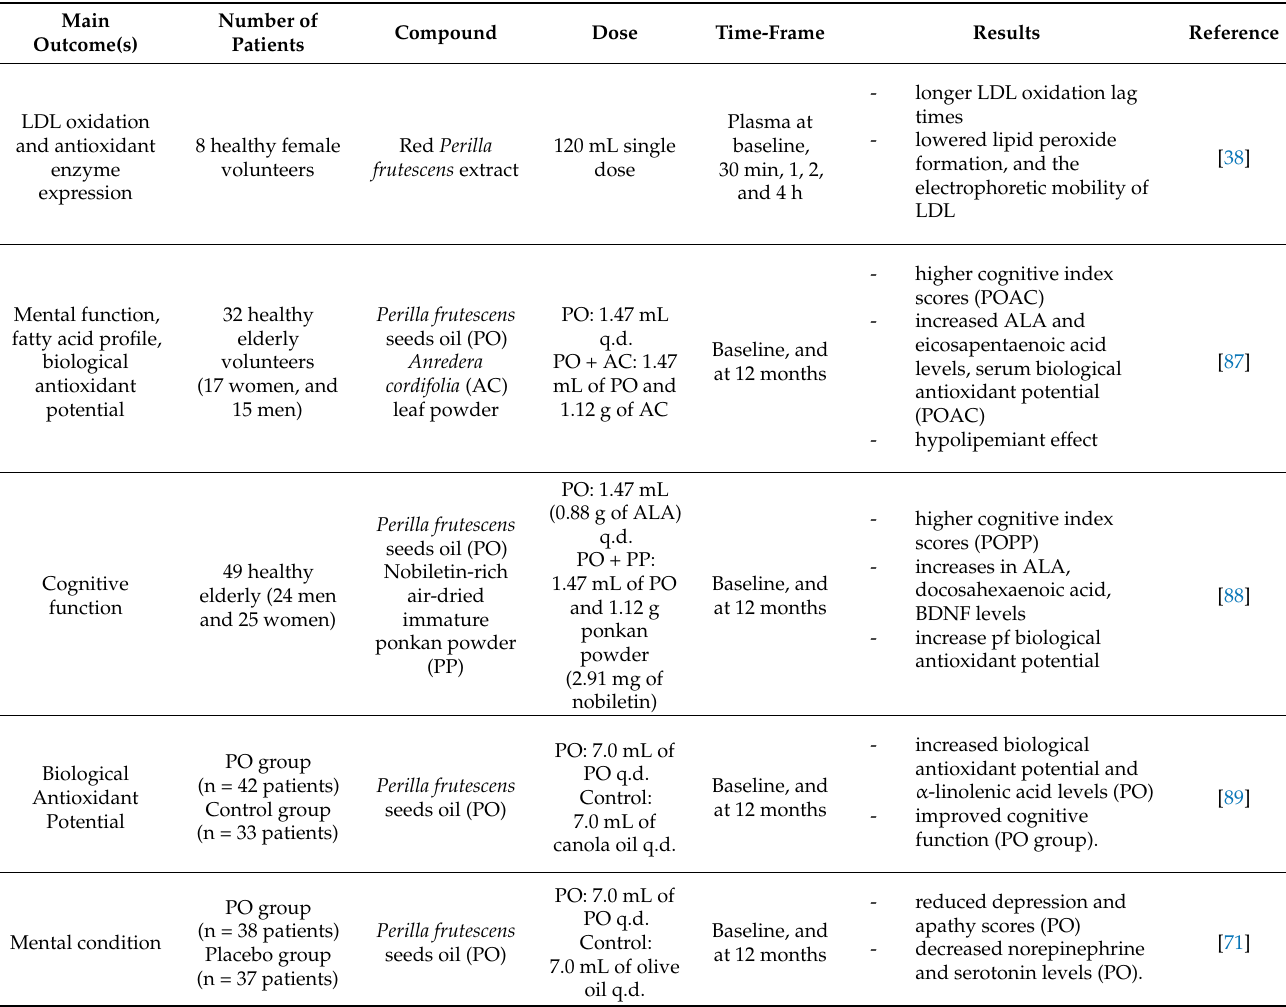
Table 3. Summary of evidence from studies performed in human subjects regarding the Perilla frutescens antioxidant and hypolipemiant